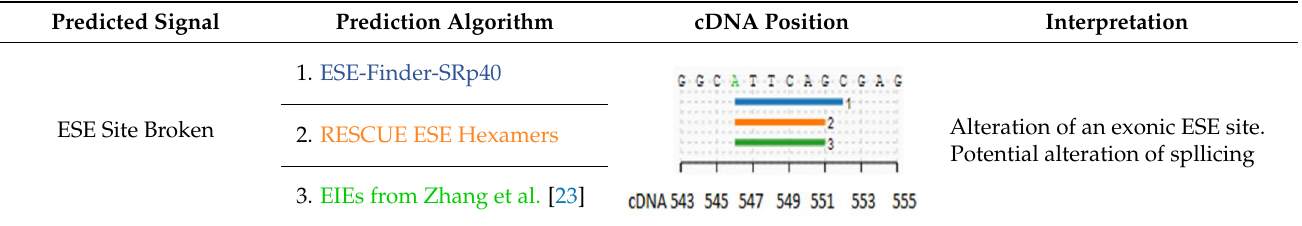
Table 2. Splicing analysis of the exon 3 sequence of the VSX1 and its SNP c.546A>G, effect on the ESE site the formation of splicing regulatory complex.